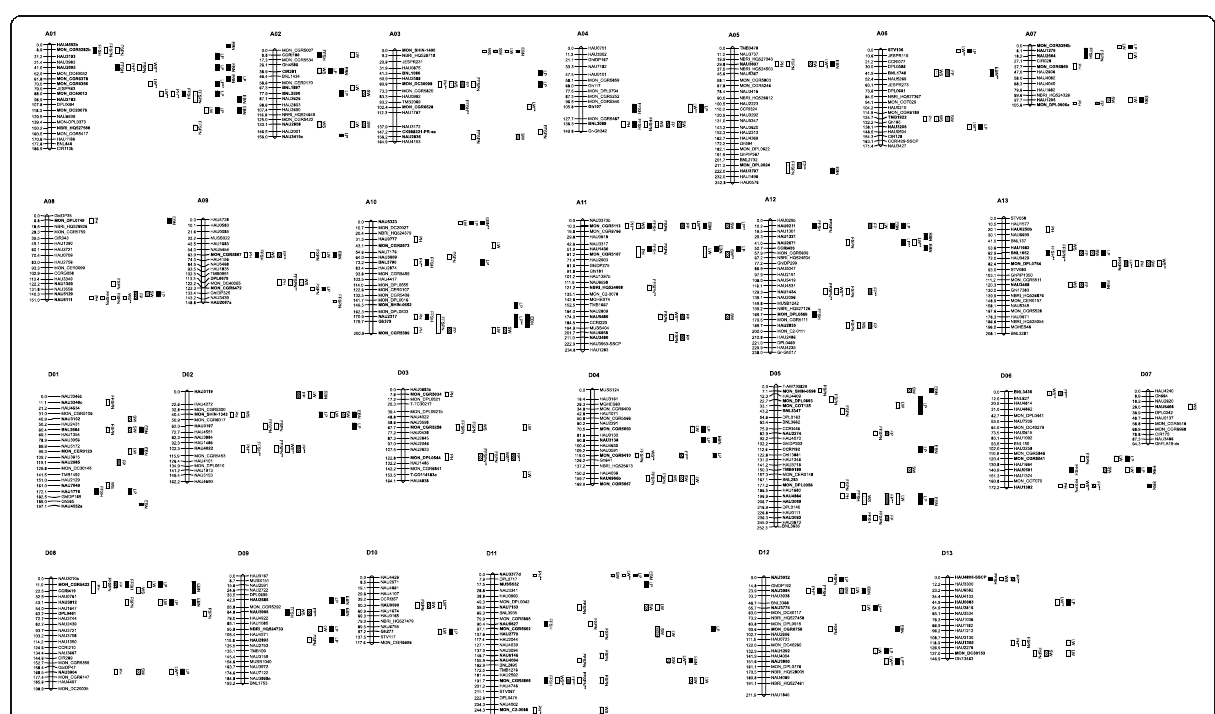
Fig. 3 The distribution of the SSR markers associated with the yield-related traits on 26 chromosomes of upland